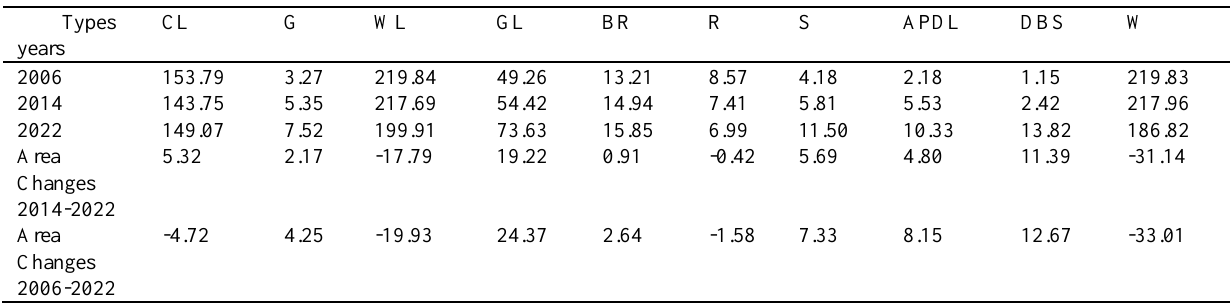
Table 3. The area statistics of land use type (Unit: /square